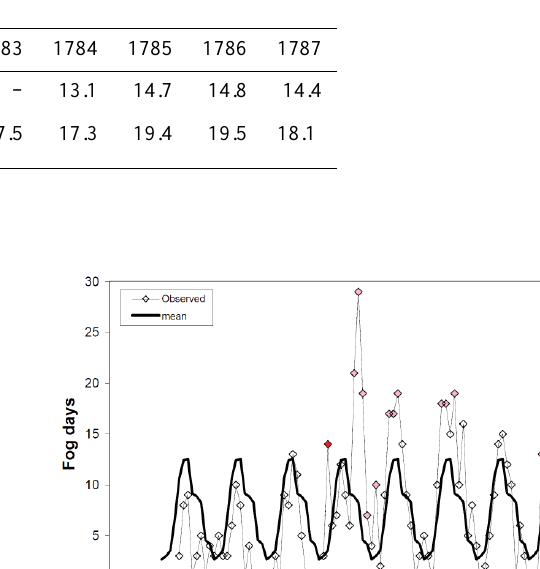
Table 2. Mean annual and summer temperatures ( ◦ C) in Mafra (Taborda et al., 2004).